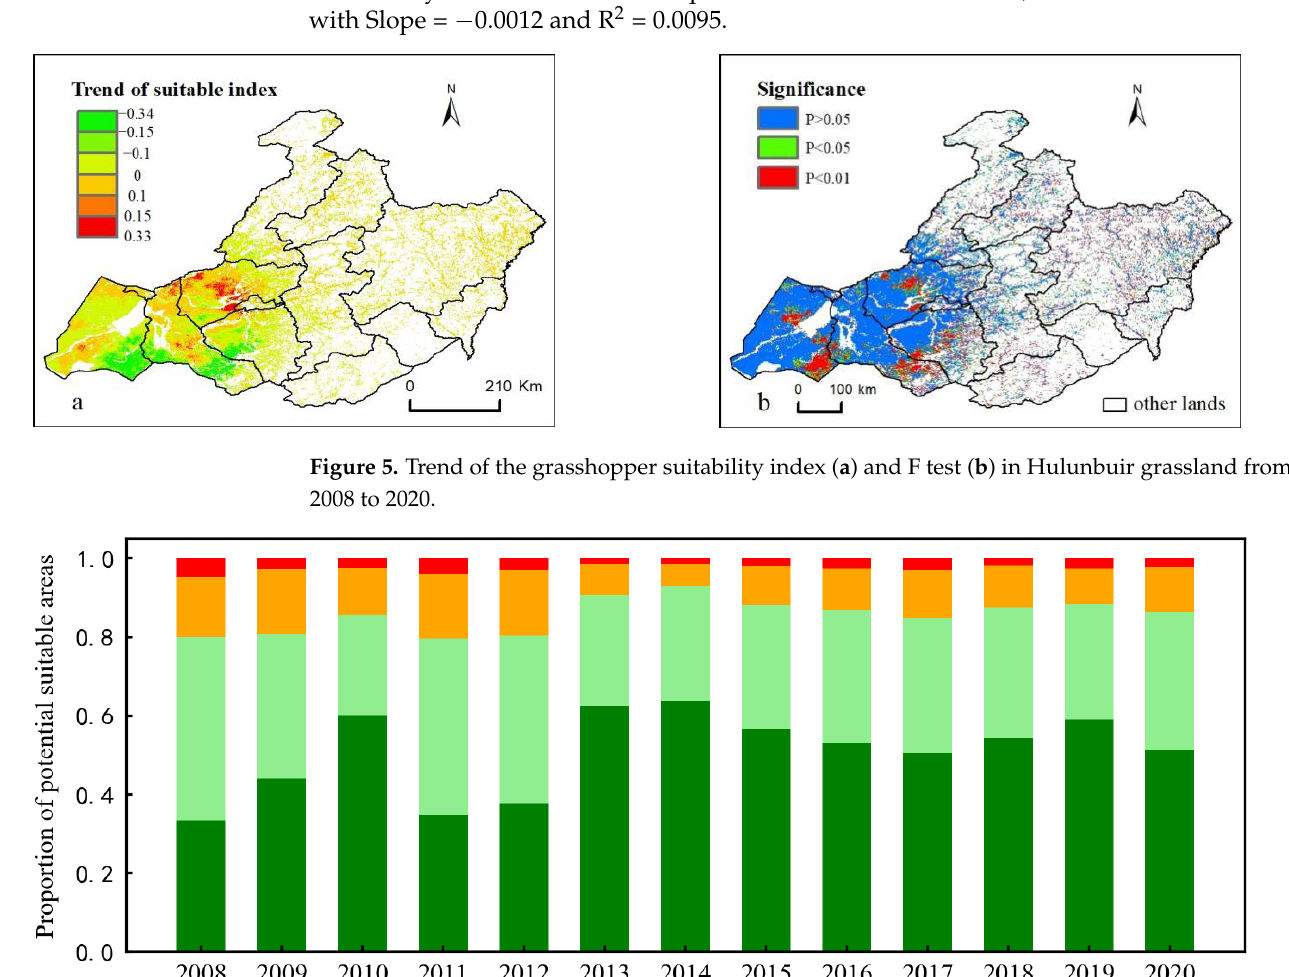
Figure 5. Trend of the grasshopper suitability index ( a ) and F test ( b ) in Hulunbuir grassland from